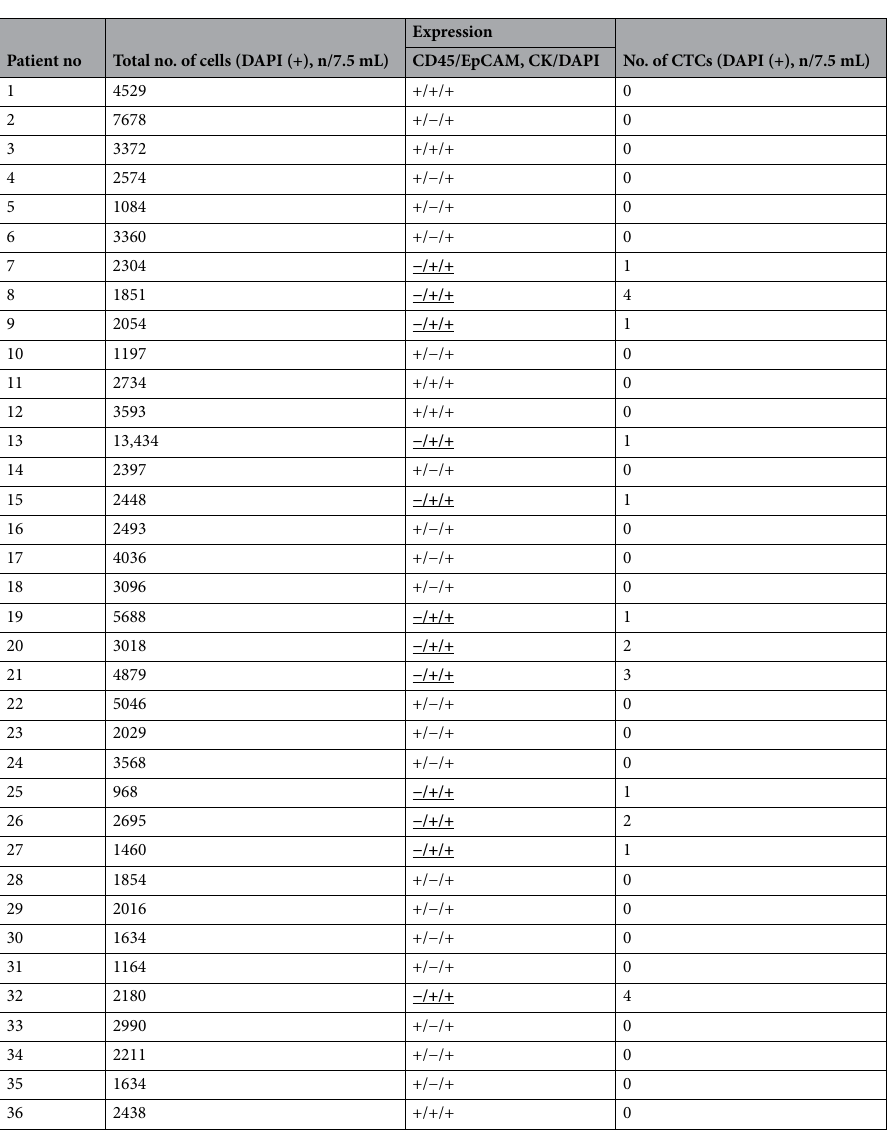
Table 2. Detected number of circulating tumour cells (CTCs) in the blood of each patient. (Among 36 patients, the CTC-positive group included patients with EpCAM/CK (+) and CD45 (−) cell (N = 12). The CTC- negative group included patients with EpCAM/CK (−) and CD45 (+ or −) cell (N =